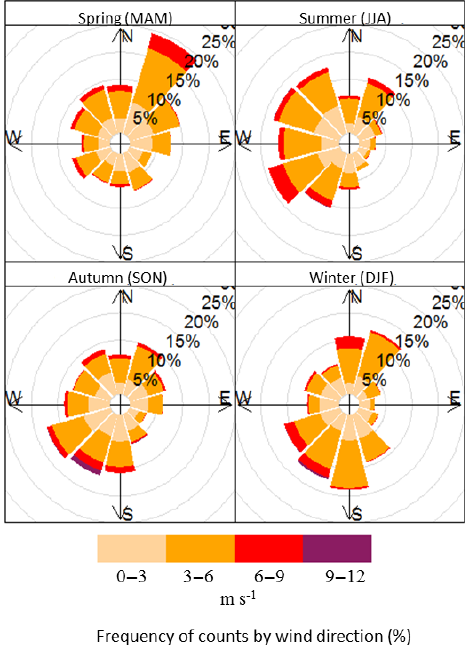
Figure 3. Wind rose at GIF (7ma.g.l., SW peri-urban site) given by season over the period of study (8 August 2010–13 July 2011) from the Meso-NH modeled wind fields. Colors indicate the wind speed according to the given scale (in ms − 1 )